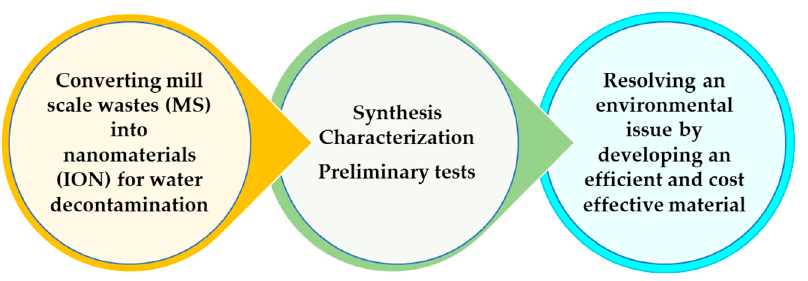
Figure 1. Illustration of the recycling process from mill scale waste to absorbent for the removal of heavy metal ions from waters.